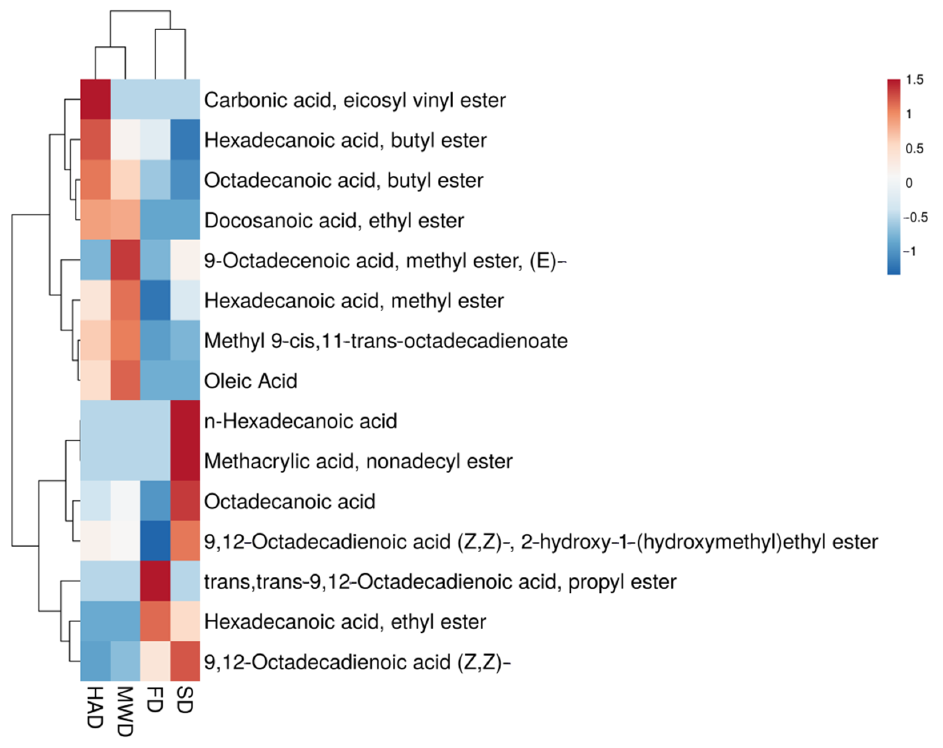
Figure 7. Heat map of fatty acids and fatty acid esters of Pleurotus ostreatus powder lipophilic extracts. FD—freeze drying; HAD—hot air drying; MWD—microwave drying; SD—sun drying. The increase and decrease in the content of substances are shown in red and blue, respectively.